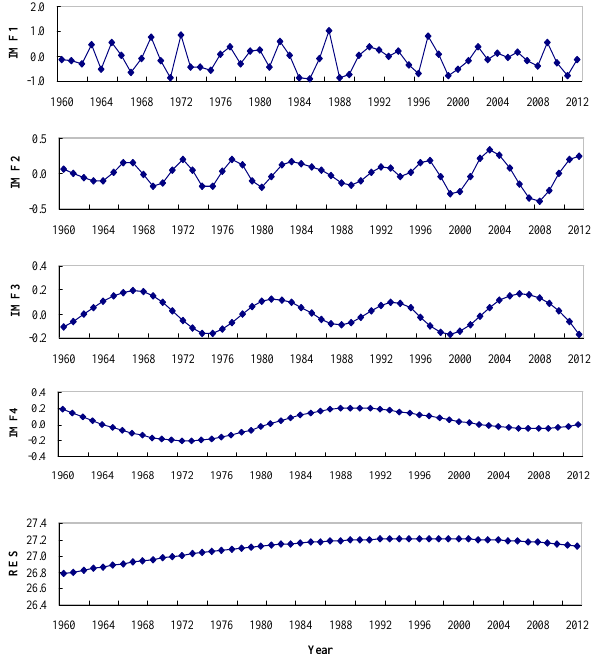
Figure 9. The EEMD results for the NINO3.4 index data series dur- ing 1960–2012.